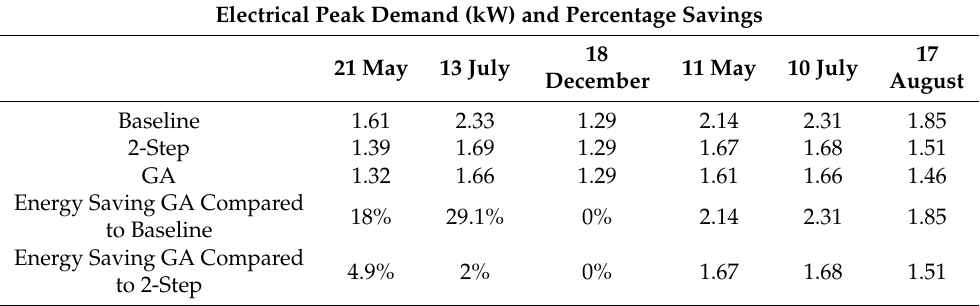
Table 7. Electrical peak demand for baseline windows and STIS–smart windows applied to a house in San Francisco, CA, USA for six representative days using two control